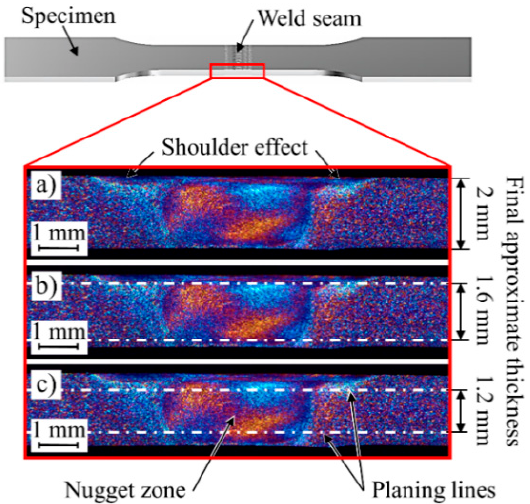
Figure 6. Approximate thickness of ( a ) as-welded, ( b ) 200 µ m and ( c ) 400 µ m finished specimens.